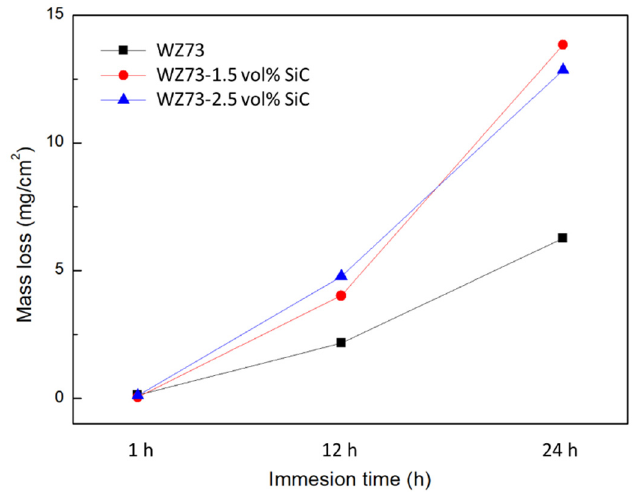
Figure 11. Mass losses of WZ73, WZ73-1.5 vol% SiC, and WZ73-2.5 vol% SiC alloys as a function of immersion time in a 1 wt % NaCl solution.